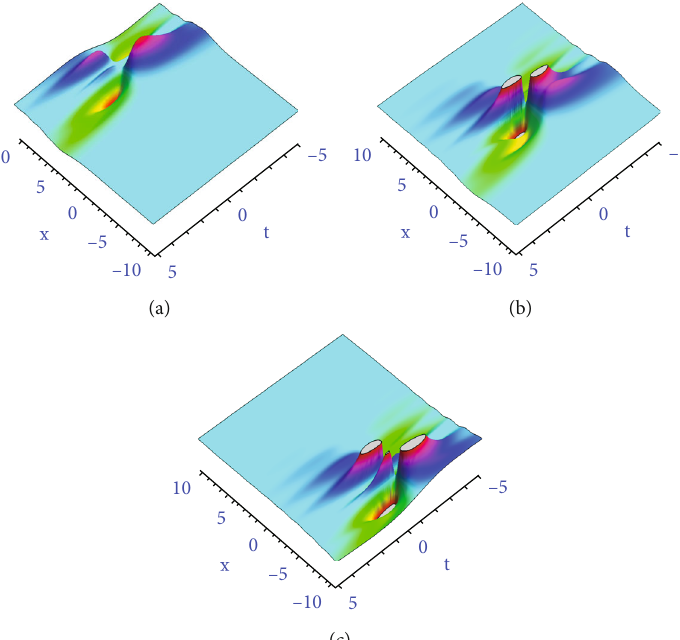
= α = α = α = k = 1 , k 1 4 11 9 1